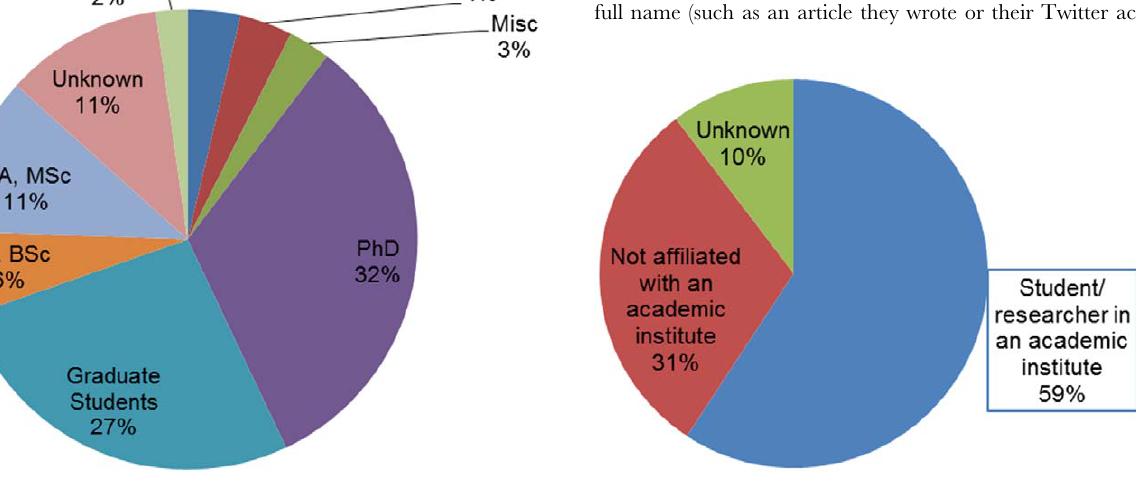
Figure 4. Distribution of bloggers’ education levels. doi:10.1371/journal.pone.0035869.g004 PLoS ONE |